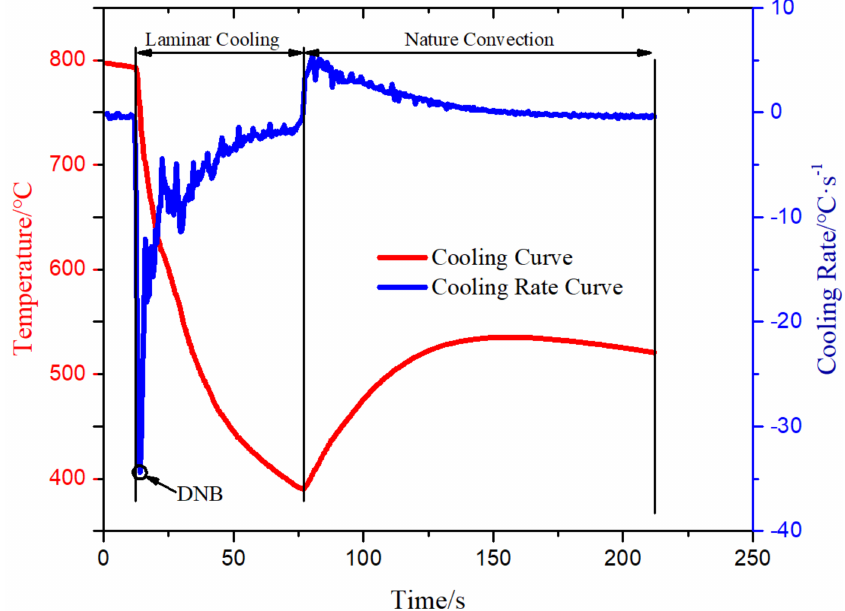
Figure 3. Curves of the cooling temperature and the temperature rate for